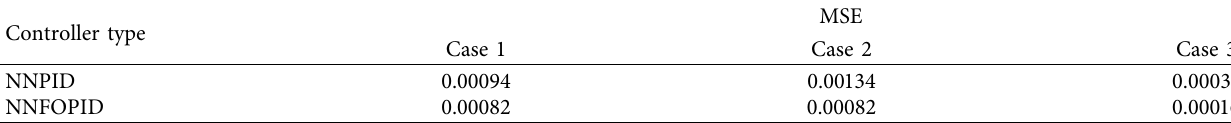
Table 3: MSE for NNPID and NNFOPID controllers with MAPSO.